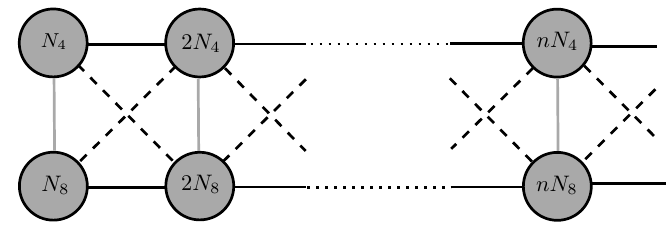
Figure 3 . In(cid:12)nite quiver associated to the NATD